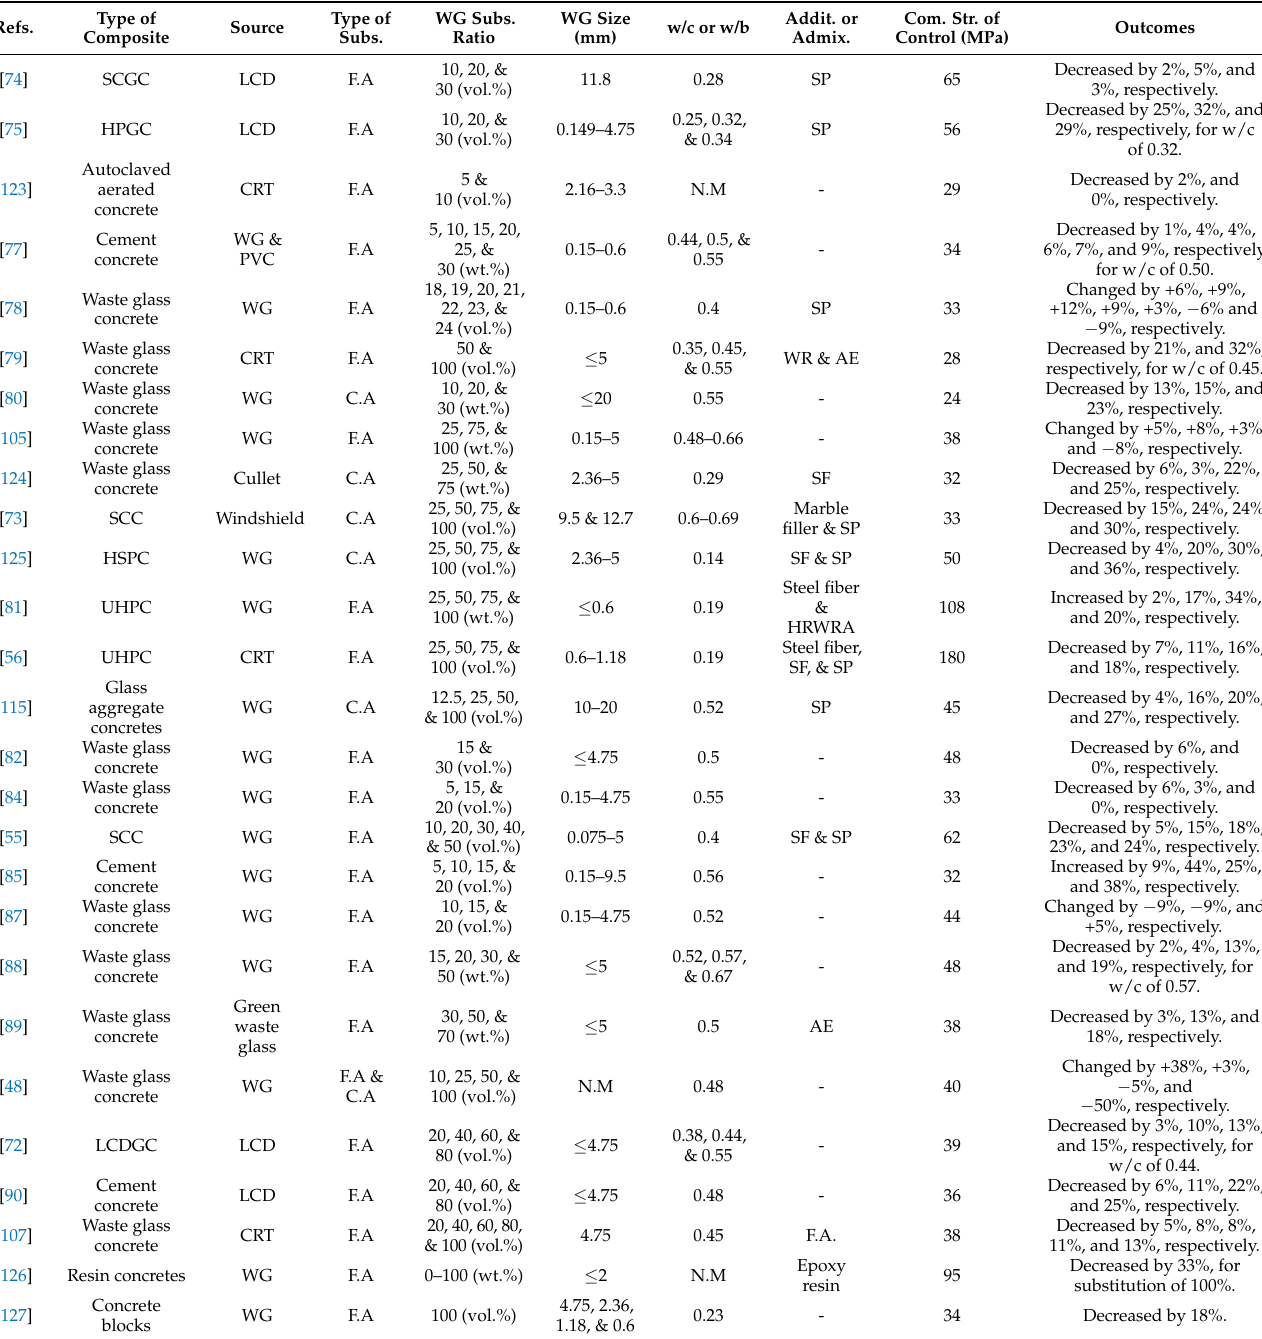
Table 6. Summary of the results of past studies on the compressive strength of waste-glass